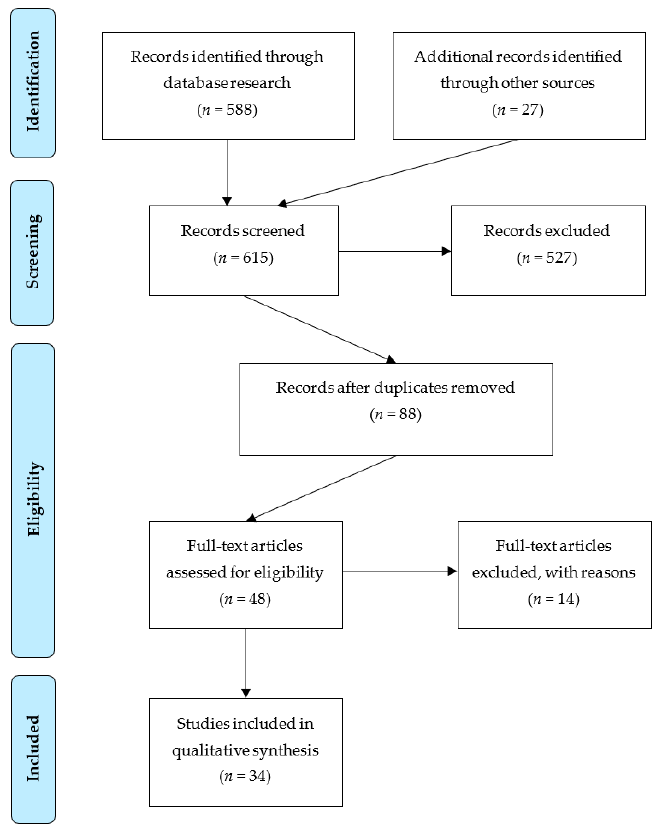
Figure 1. Research process. Flow diagram inspired by PRISMA 2009 Flow Diagram. [21] .